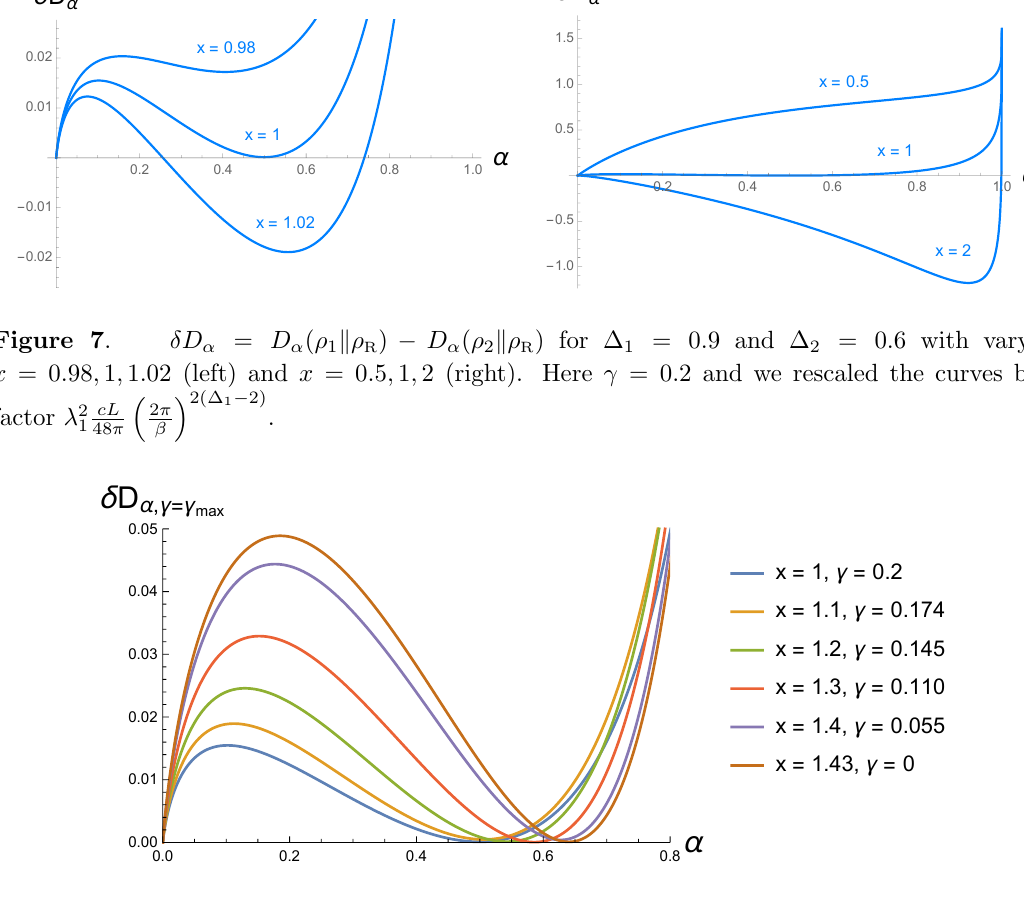
Figure 8 . (cid:14)D (cid:11) = D (cid:11) ( (cid:26) 1 k (cid:26) ) (cid:0) D (cid:11) ( (cid:26) 2 k (cid:26) ) for (cid:1) 1 = 0 : 9 and (cid:1) 2 = 0 : 6, with varying x and R R (cid:13) = (cid:13) . For x & 1 : 43 there is no (cid:13) such that (cid:14)D (cid:11) is non-negative in the whole range 0 (cid:20) max (cid:11) (cid:20) 1, and thus the transition is forbidden. As in the previous plots, we rescaled the curves by a (cid:16) (cid:17) 2((cid:1) 1 (cid:0) 2) cL 2 (cid:25) factor (cid:21) 2 . 1 48 (cid:25) (cid:12)